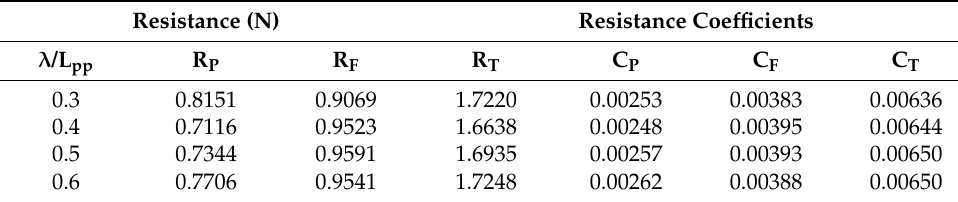
Table 6. Computed ship resistance of the original model under wave conditions.